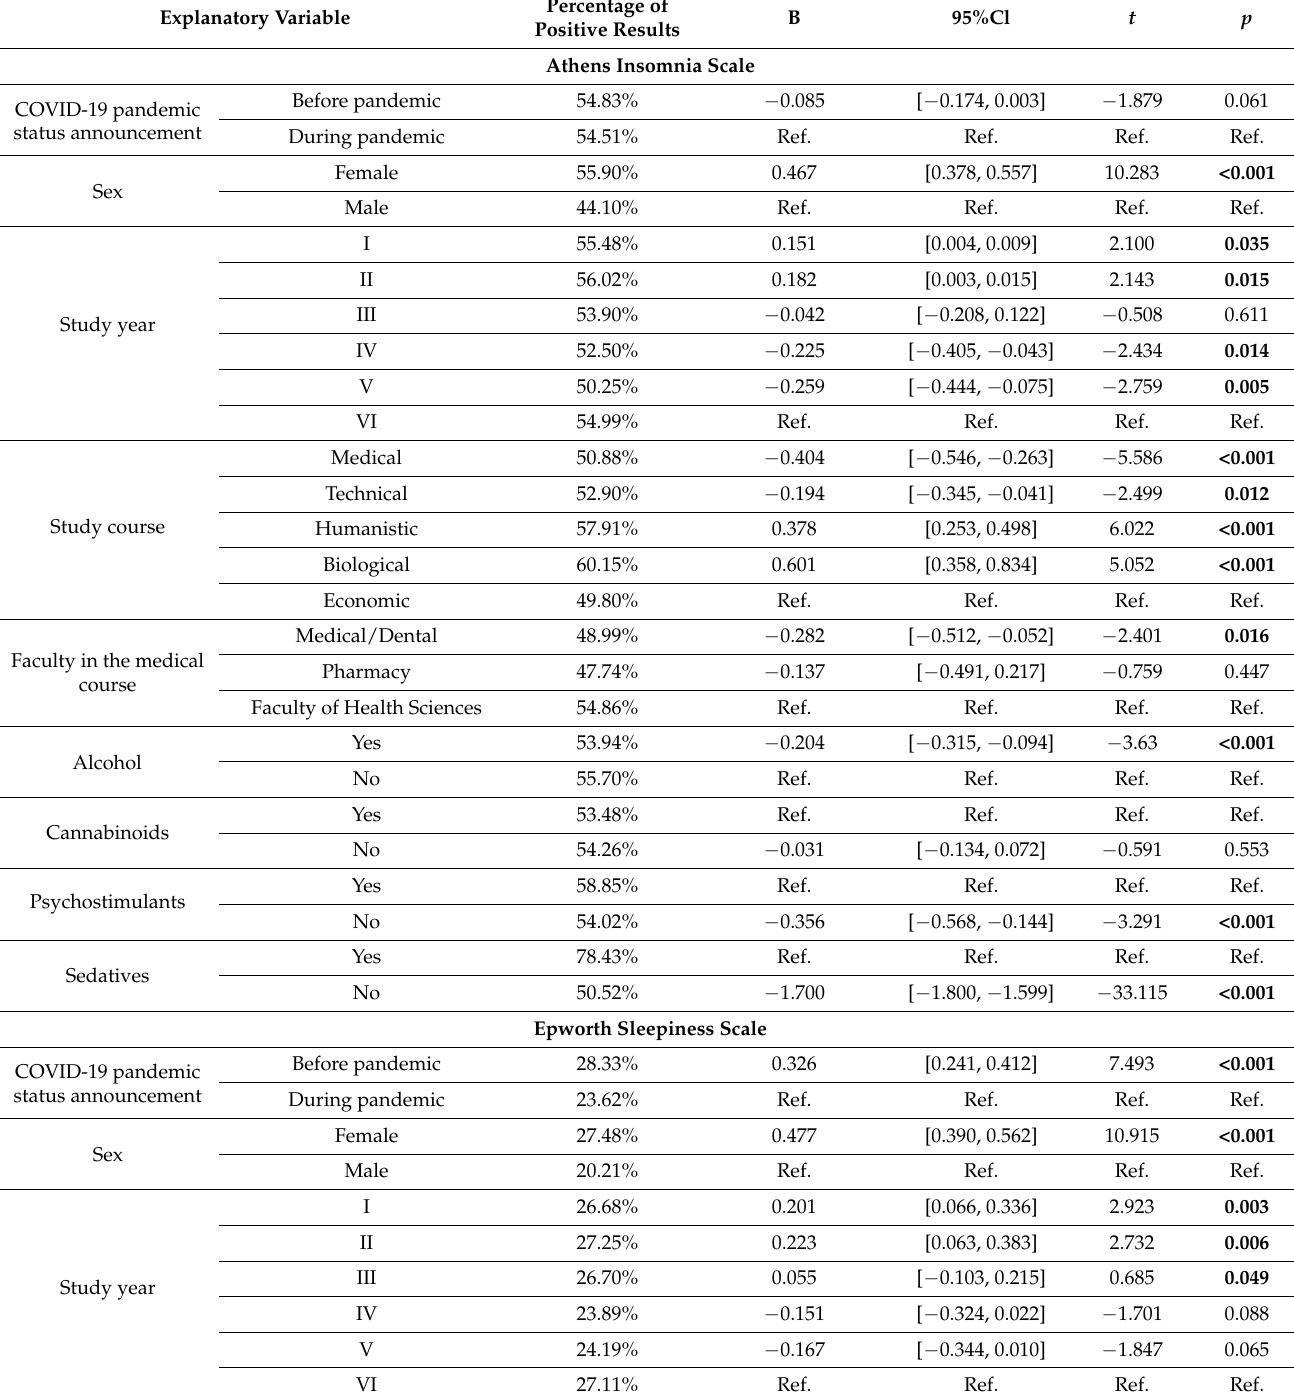
Table 2. Linear regression model of the influence of sociodemographics and stimulants on AIS and ESS scales. Percentage of Explanatory Variable Positive